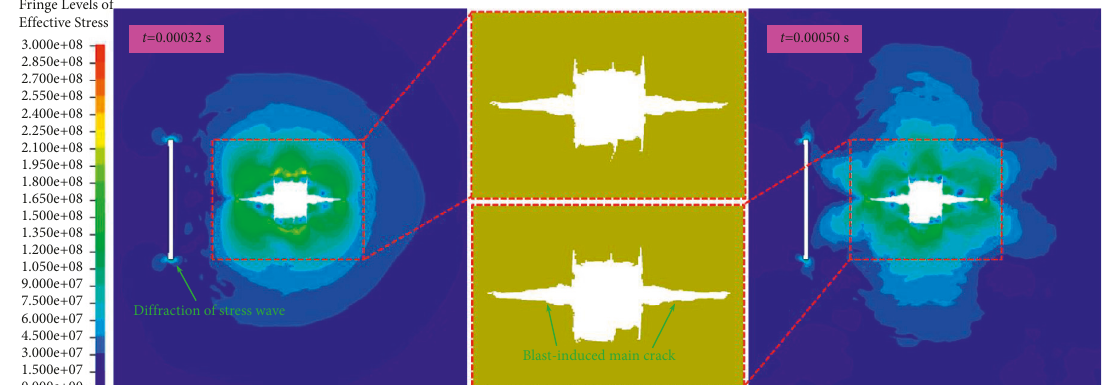
Figure 14: Pressure diagram of explosion stress wave transmission for case CN